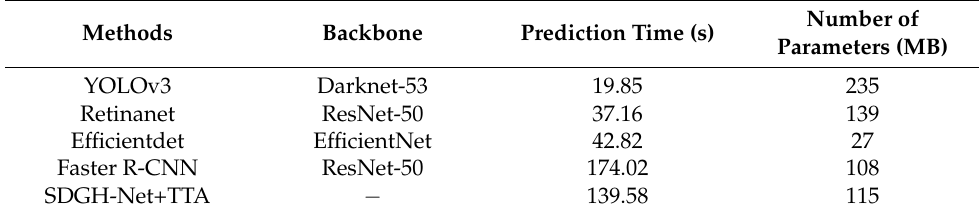
Table 2. Prediction time for test set of all methods.